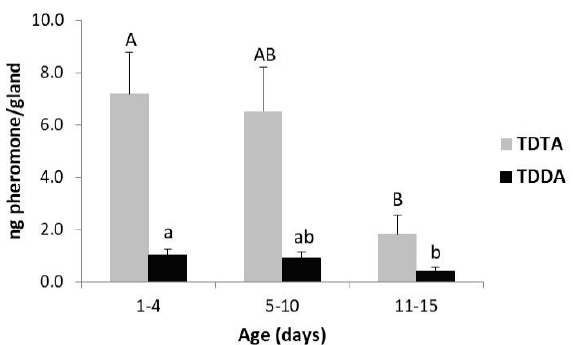
Figure 1. Pheromone contents (mean + SE) of gland extracts of T. absoluta females at different ages (N = 8, 4, and 6 for 1–4, 5–10, and 11–15 days of age, respectively). Glands were excised 2 h after the onset of the scotophase. Means followed by the same letter are not significantly different (Tukey test post hoc test, p < 0.05).